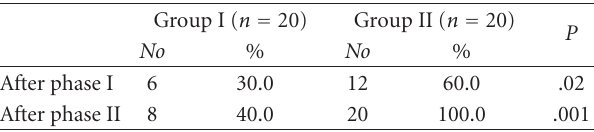
Table 3: Liver enzymes levels of leukemia patients after phases I and II of chemotherapy.